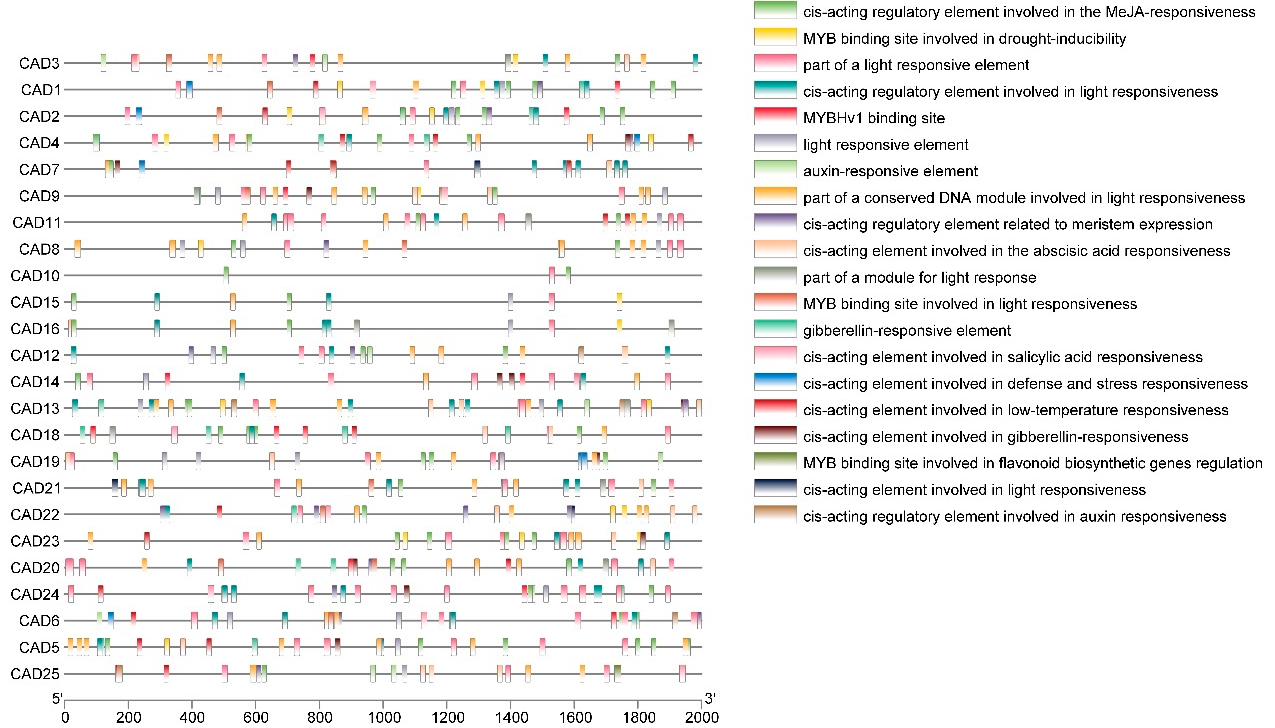
Figure 5. Cis-acting elements in promoter regions of PgCAD . The color blocks on the right indicate the different cis-acting elements. The scale at the bottom indicates the sequence length.